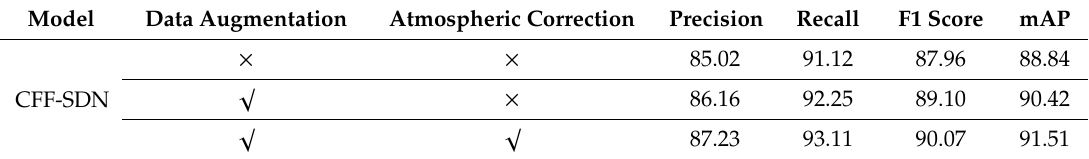
Table 6. The e ff ect of data augmentation and atmospheric correction for CFF-SDN